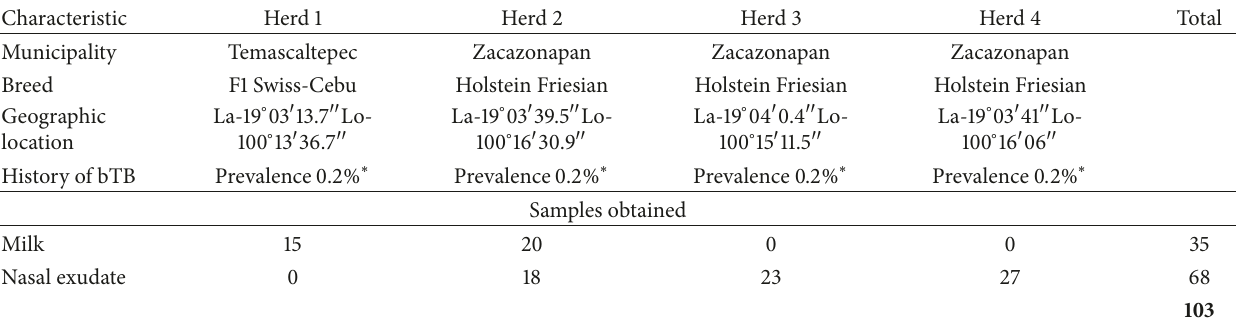
Table 1: Samples collected in cattle herds in the south region of the State of